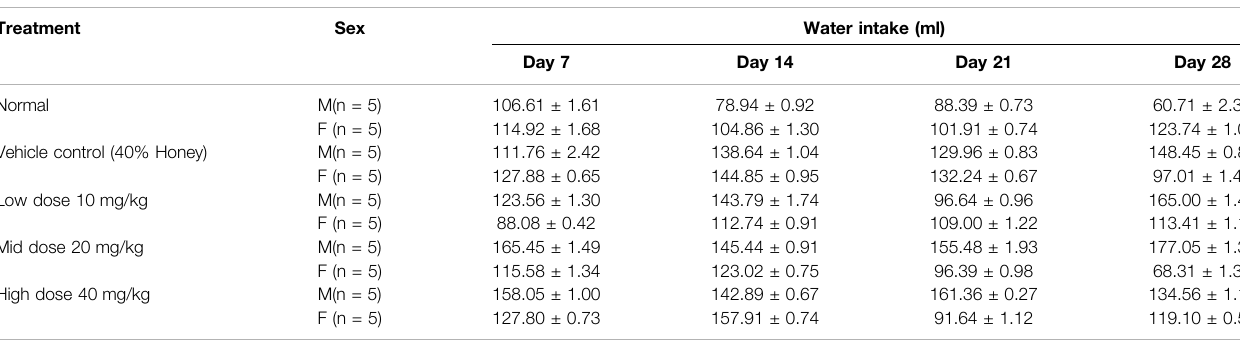
TABLE 3 | Effect of in-house Thamira parpam on water intake.